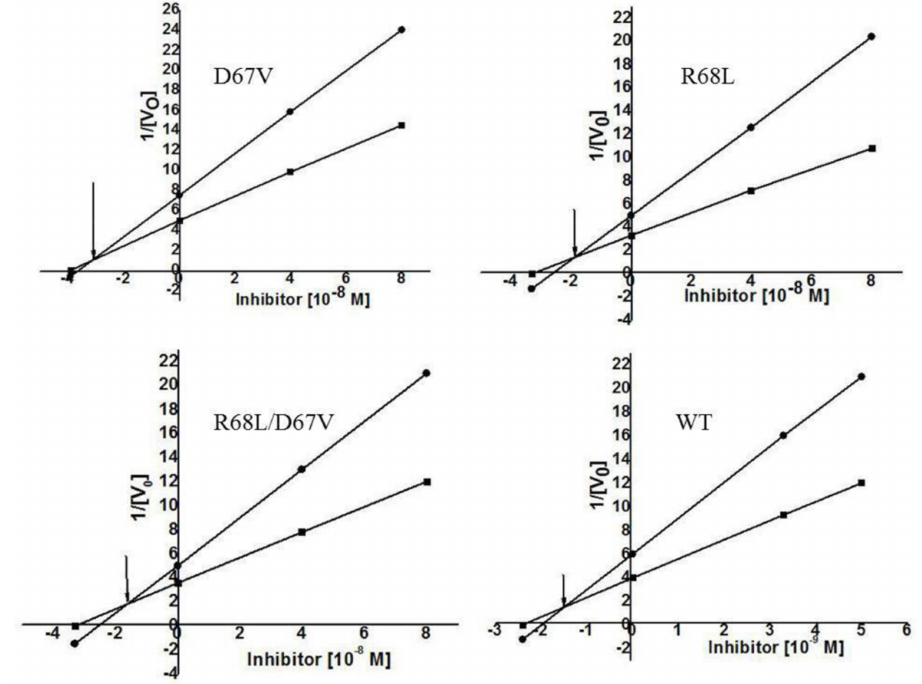
Figure 3. Kinetic analysis of the trypsin inhibitory activity of FtTI . Dixon plot for the determination of the dissociation constant ( Ki ) values of FtTI at two different concentrations of N - α -benzoyl-L-arginine ethyl ester hydrochloride. Final substrate concentrations were 0.01 M ( (cid:4) ) and 0.005 M ( (cid:78) ). The reciprocals of velocity were plotted against different concentrations of FtTI